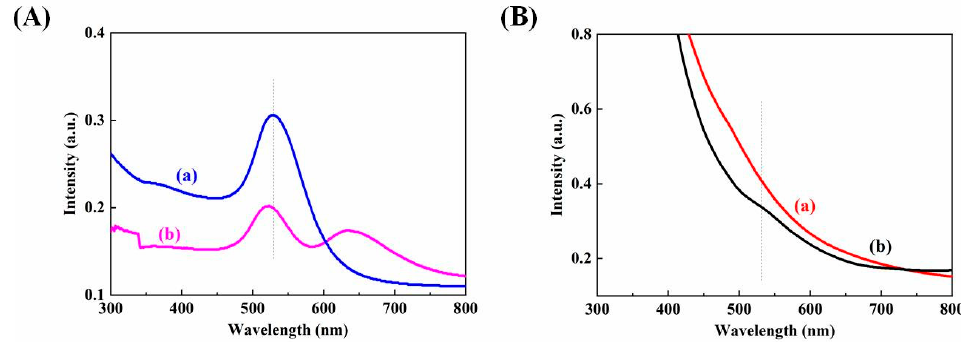
Figure 3. UV–visible spectra: ( A ) Au NPs (a) and ITO/Au (b); ( B ) Fe 3 O 4 (a) and Fe 3 O 4 @Au (b).